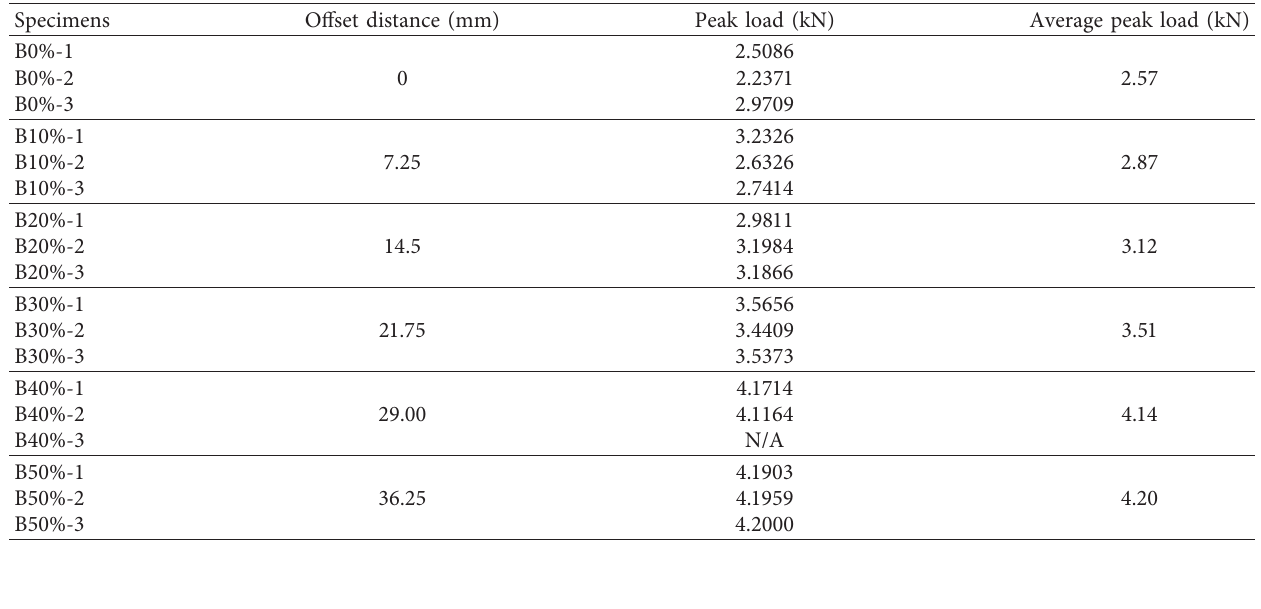
Figure 1: Specimens design and experimental setup. (a) Specimens with one single offset notch. (b) Specimens with central and offset double Table 1: Peak loads for the specimens with one single offset notch.